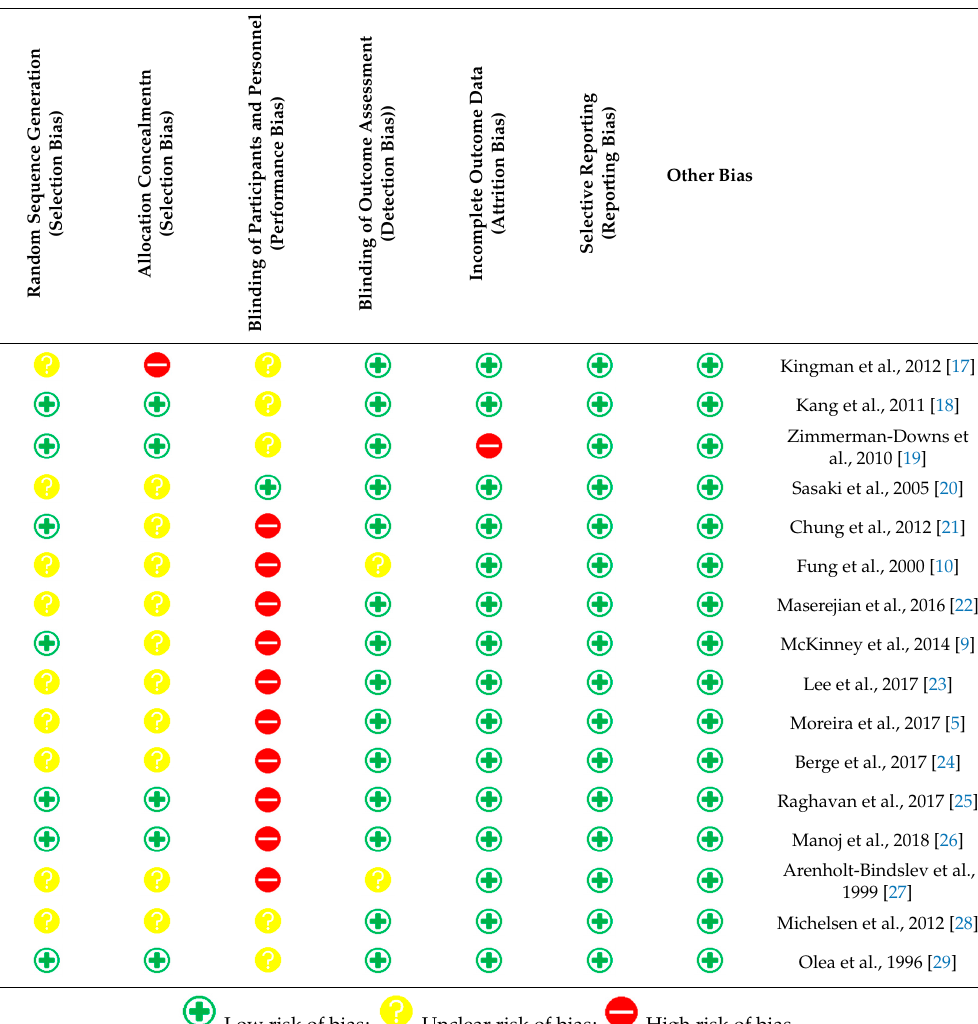
Table 2. Evaluation of quality assessment of randomized controlled trial (RCT) studies of the systematic review.